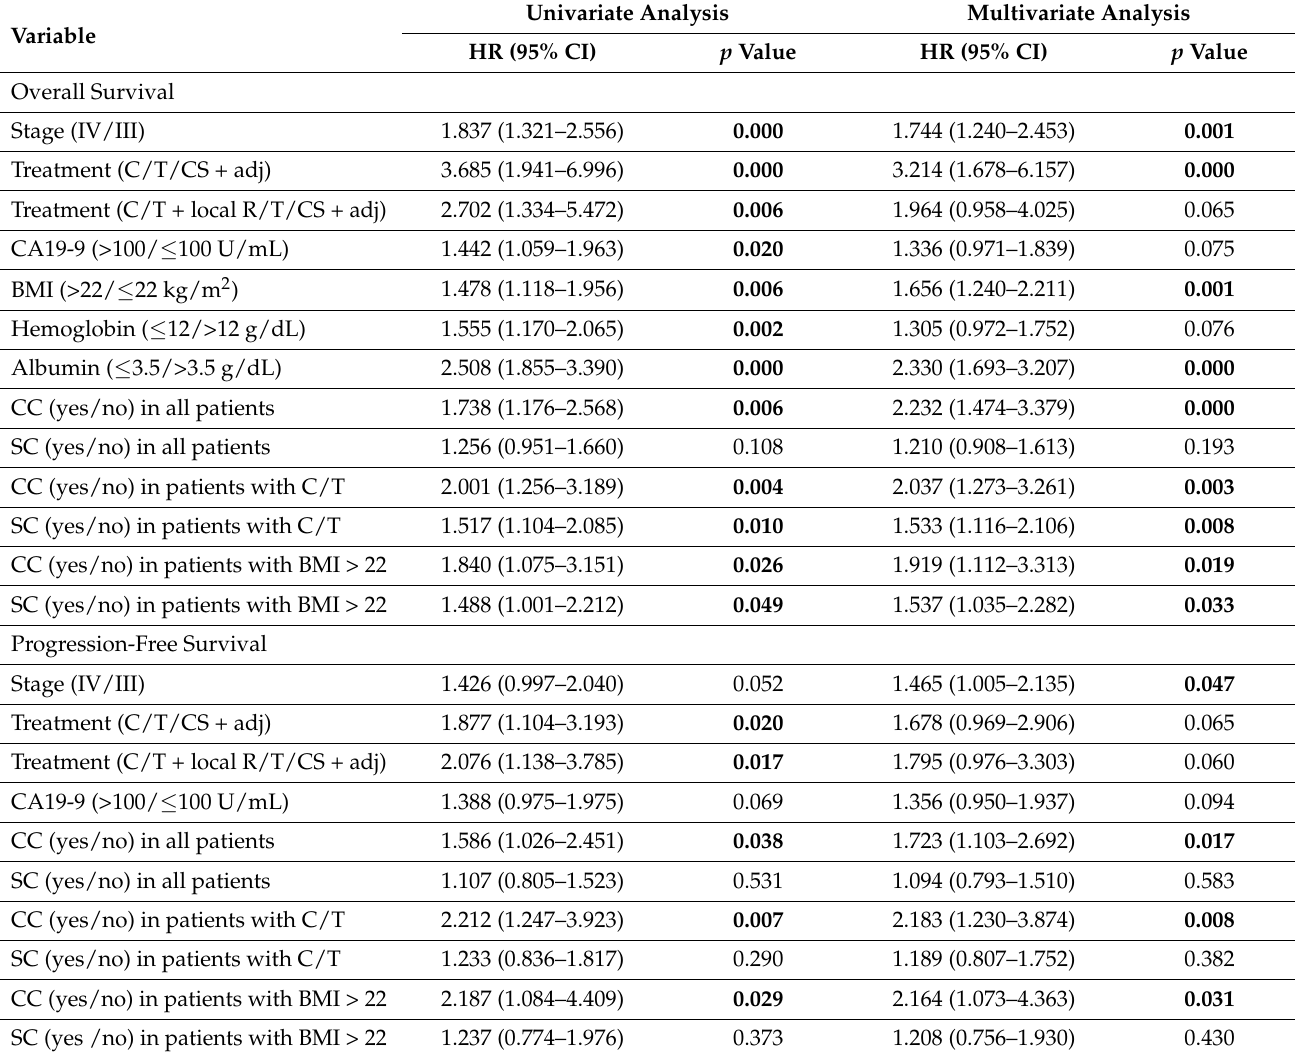
Table 4. Univariate and multivariate analysis of the overall survival and progression-free survival in patients with advanced pancreatic